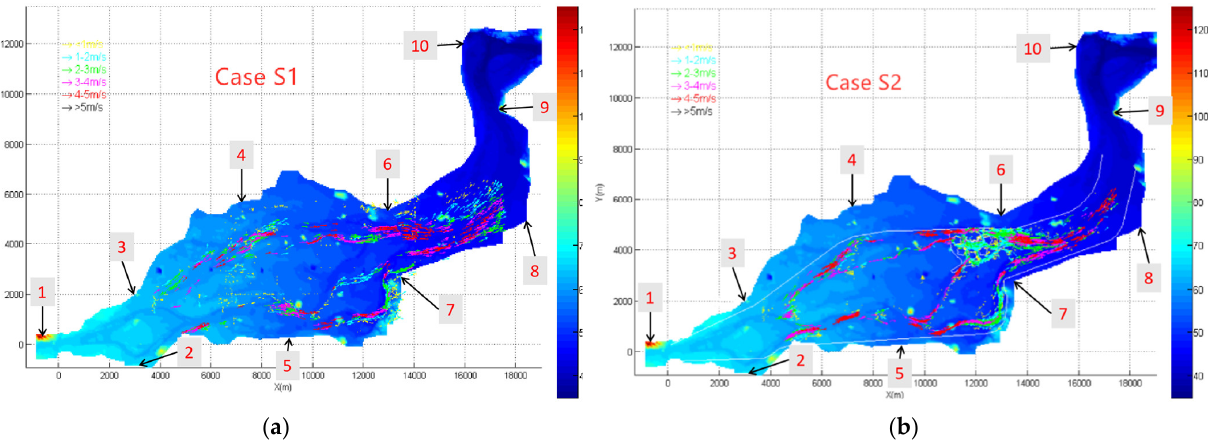
Figure 7. The flow field (water level and velocity) for cases S1 and S2 for the design flood. ( a ) Case S1; ( b ) Case S2. Table 3. Flood level at the left and right banks ( P 2 = 2%, Q 2 = 19,000 m 3